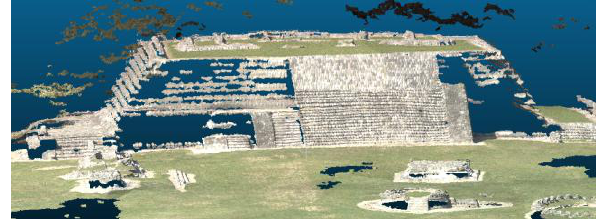
Figure 14. Detail of the 3D model of the archaeological site of